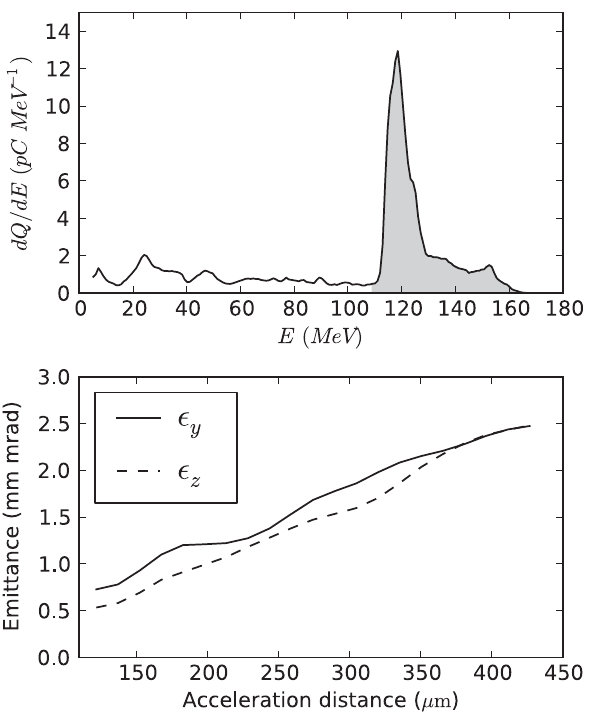
FIG. 1. Top: energy spectrum after 300 (cid:2) m of acceleration (from the position when injection started). The grayed area represents the sub-bunch for which the emittance was computed. Bottom: transverse emittance of this sub-bunch in the y (parallel to the laser polarization) and z (orthogonal to the laser polarization) direction, as a function of the acceleration distance.